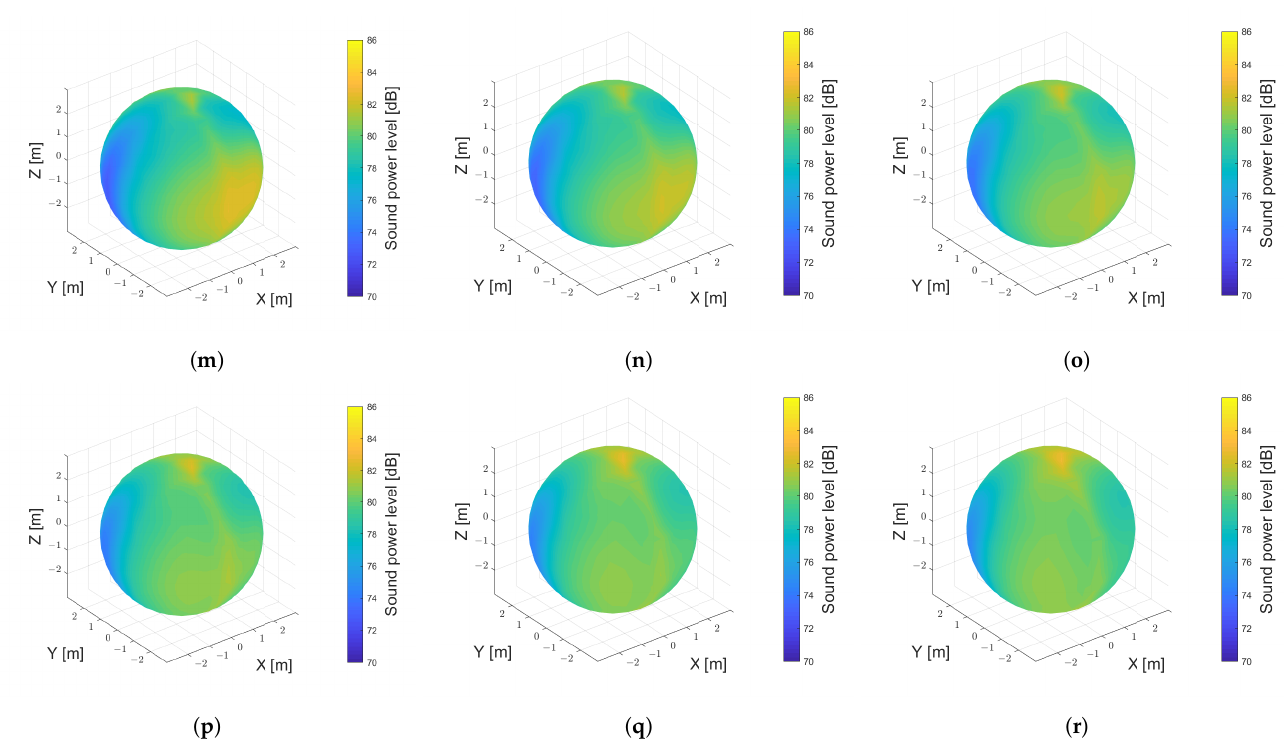
Figure 10. Sound power level distribution: ( a – r ) are the measurement points 1–18.